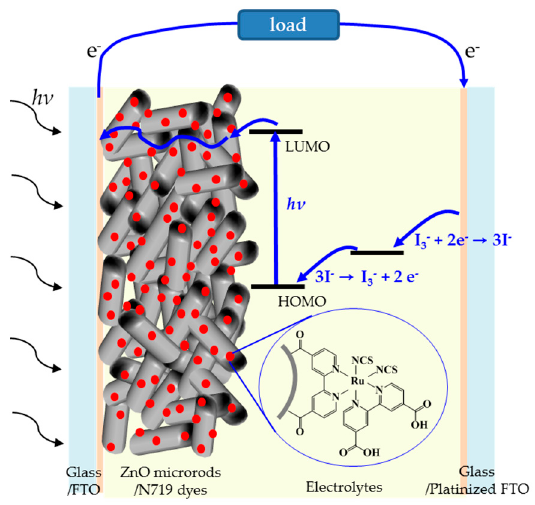
Figure 1. Structure of ZnO-based dye-sensitized solar cells (DSSC) and mechanism for light energy conversion into electric energy.